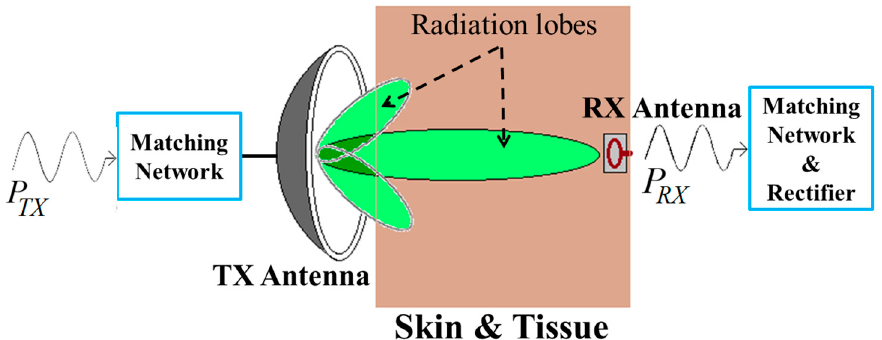
Figure 35. RFF WPT system powered by alternative EMF.